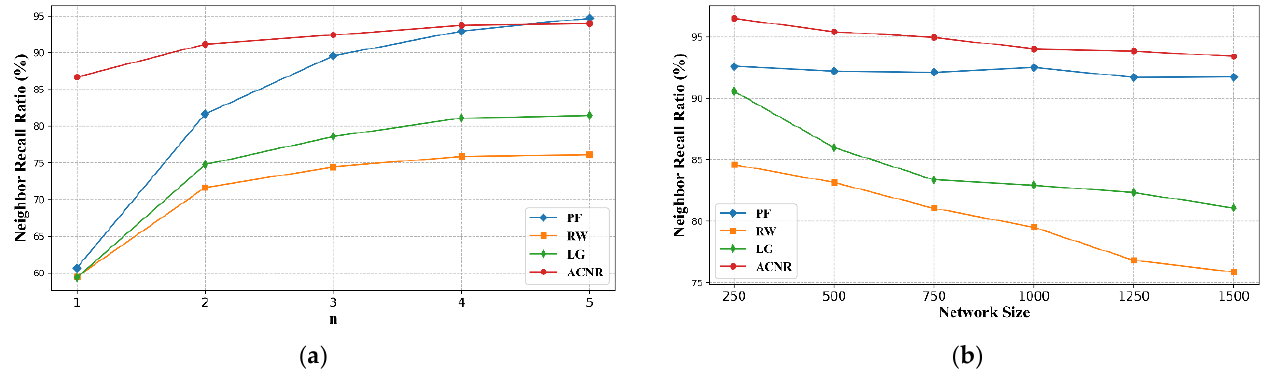
Figure 2. Latency neighbor recall ratio comparison for each algorithm. ( a ) Latency neighbor recall ratio with different discovery rounds at network size of 1500; ( b ) latency neighbor recall ratio with different network sizes at discovery round of 4.